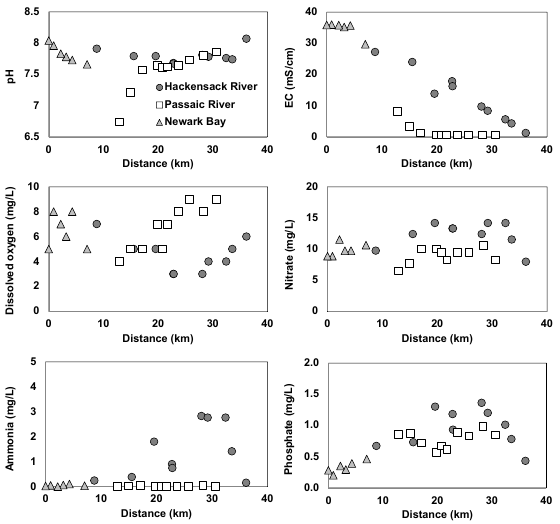
Figure 2. Variations of water quality data (pH, EC, DO, and nutrients) in summer 2016 for the Newark Bay Estuary (Hackensack River, Passaic River, and Newark Bay) as a function of the distance from the mouth of Newark Bay (NB-6).